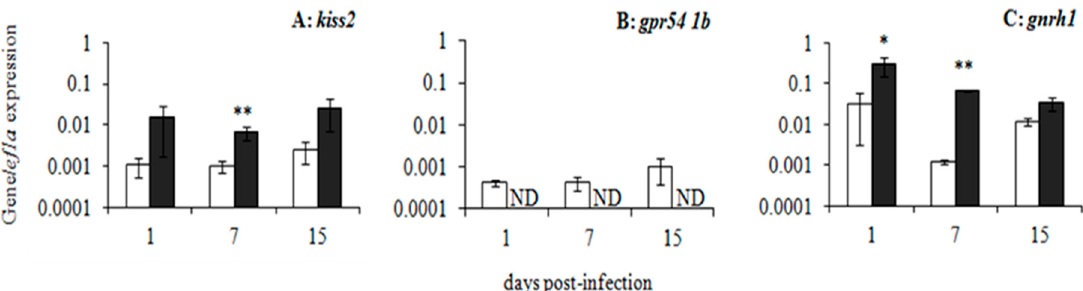
Figure 3. Expression of kisspeptin regulation route genes ( A ) kiss2 , ( B ) gpr541b , and ( C ) gnrh1 upon NNV infection in vivo in European sea bass brain. Control group was intramuscularly injected with 0.01 M PBS (white bars) and NNV group with 10 6 TCID 50 NNV/fish (black bars). Bars represent the mean ± SEM ( n = 6). Asterisks denote statistical differences between groups (* p < 0.05; ** p < 0.01). ND, undetected.